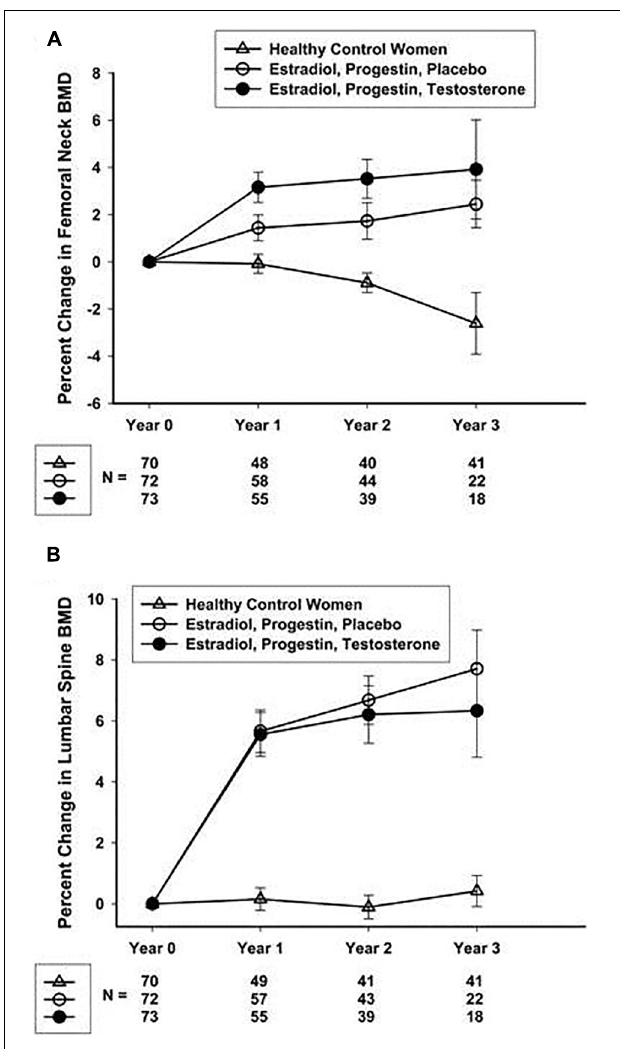
FIGURE 2 | Percentage change over 3 years in femoral neck (A) and lumbar spine (B) BMD in healthy control women and women with 46,XX sPOI treated with E + P or E + P + T. Popat et al.